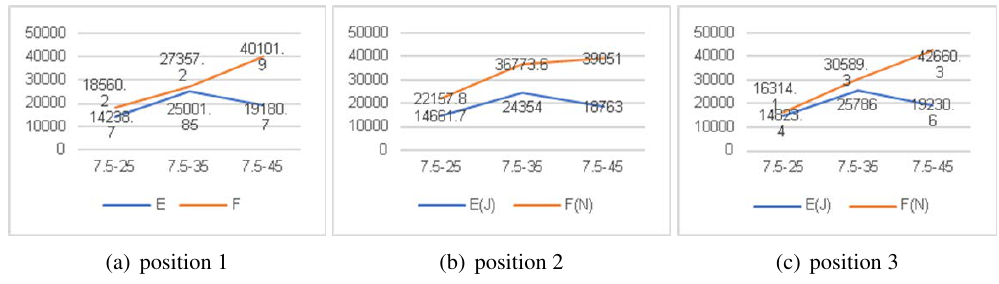
Fig. 5 Data from ‘small particles hitting large